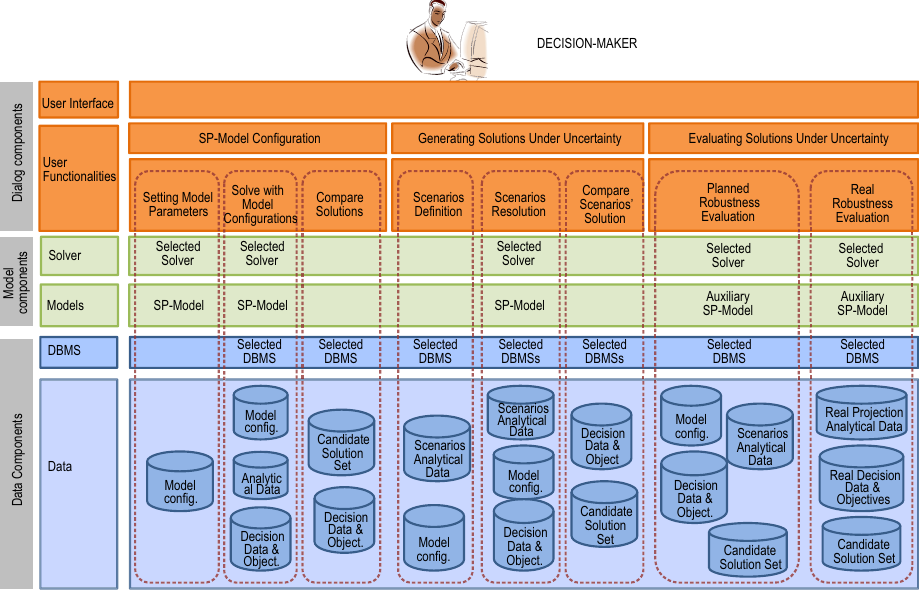
Fig. 2. The Model-Driven DSS